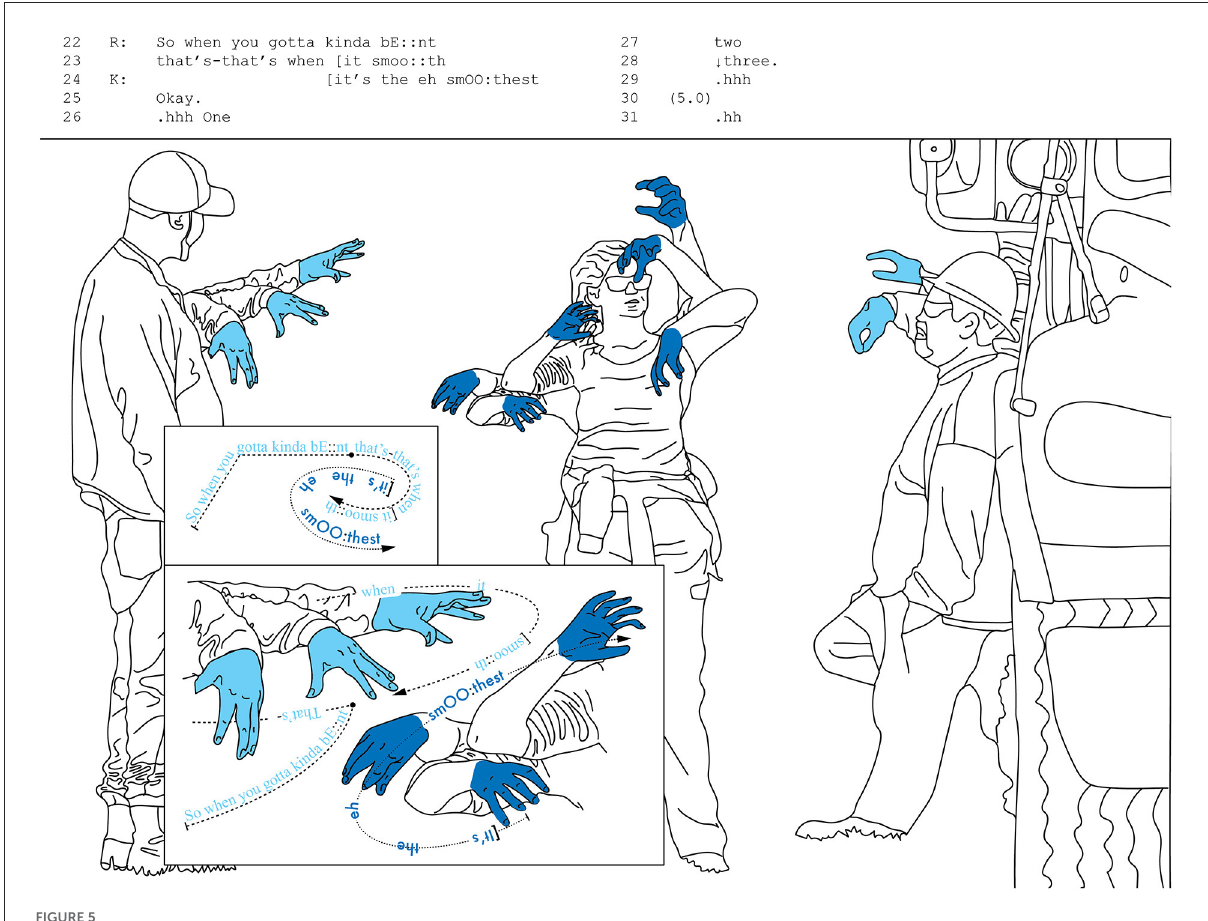
FIGURE5 Transcript